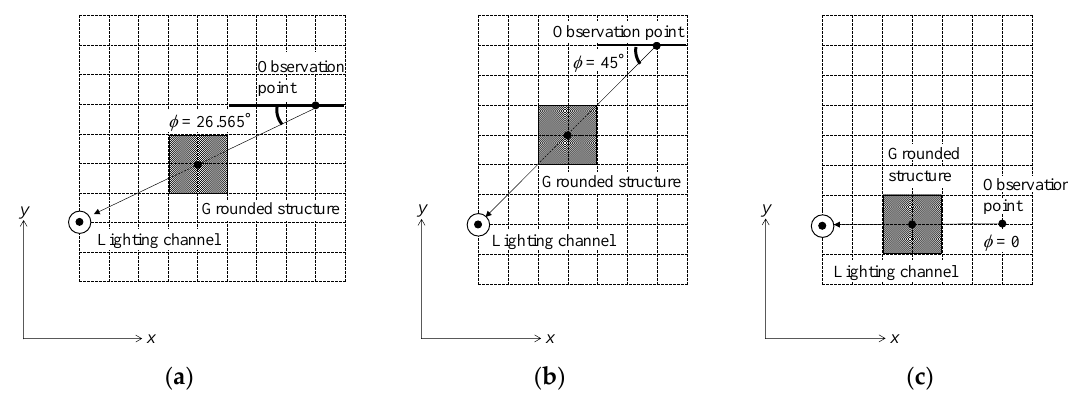
Figure 12. Illustration of locations of lightning channel, conducting structure, and observation point when the center of the structure is located on the straight line that connects the lightning channel with the observation point: ( a ) true azimuth φ is 26.6 ˝ ; ( b ) true azimuth φ is 45 ˝ ; ( c ) true azimuth φ is 0 ˝